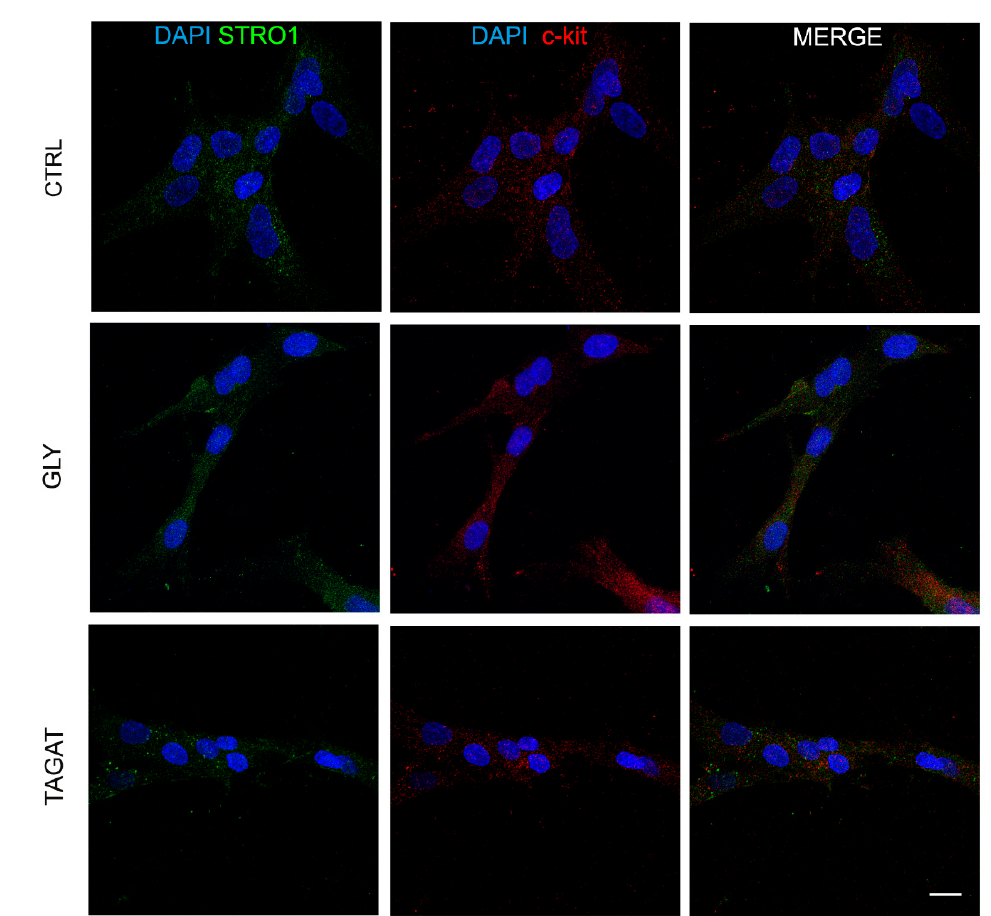
Figure 4. Assessment of stemness markers on immunoselected hDPSCs. Evaluation by immunofluorescence analysis of stemness markers STRO-1 (green) and c-Kit (red) after 48 h of culture on hDPSCs seeded on titanium disks previously cleansed with GLY and TAGAT. Control group (CTRL) consisting of hDPSCs seeded on untreated titanium surfaces. Nuclei were counterstained with DAPI. Scale bar = 10 µm.